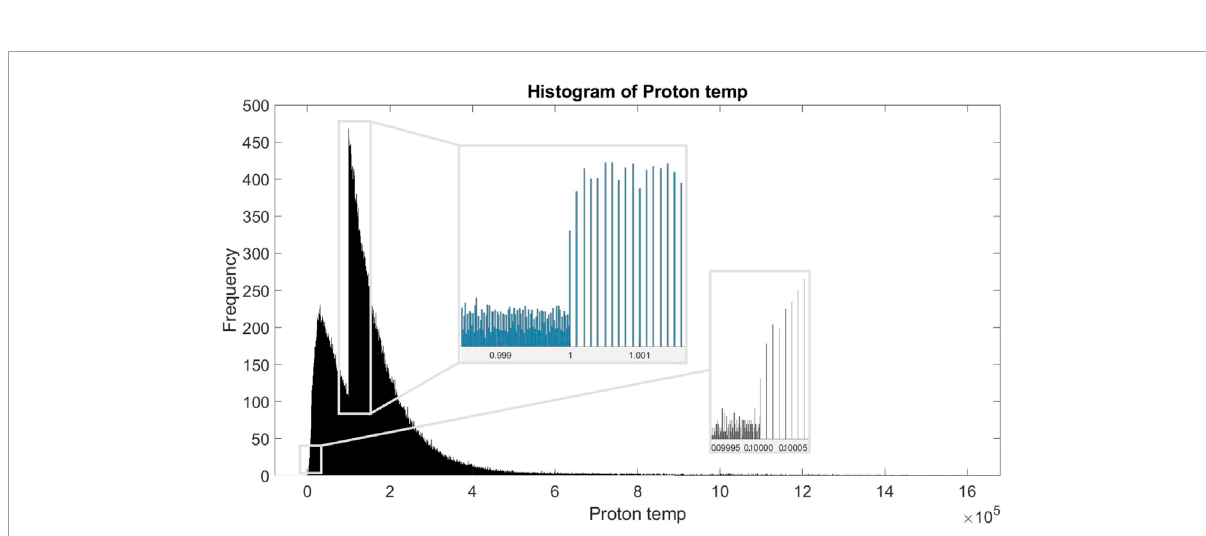
FIGURE 4 Same histogram of ion temperature than S.4 using 1,000,000 bins. Figure is zoomed on two specific zones, highlighting the changes in order of magnitude when rounding the